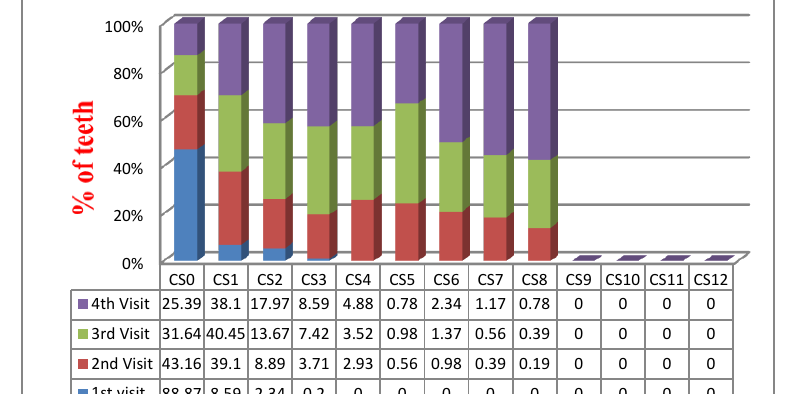
Figure1 demonstrated the cumulative white spot lesions per teeth during four time intervals. The results revealed that teeth with cumulative scores equal to zero (free of white spot lesions) were high in the first visit 88.87%. This declined